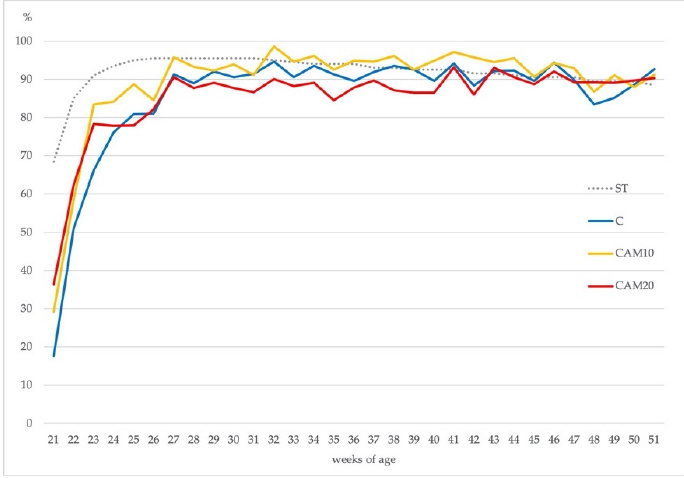
Figure 2. Hen-day egg production (%) in the Control diet (C) and camelina diets (CAM10 and CAM20) vs. Hy-Line ® brown standard (ST). vs. Hy-Line ® brown standard